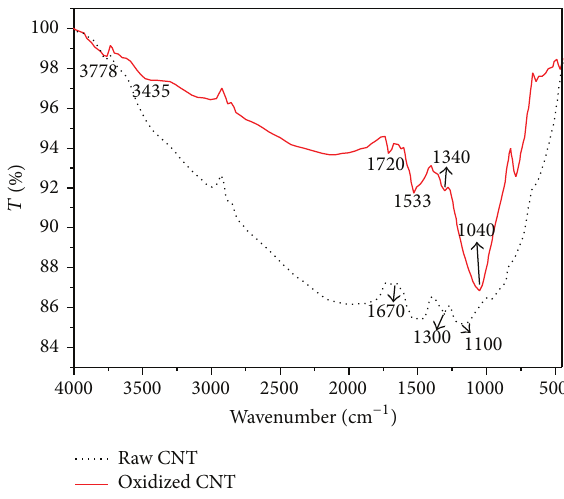
Figure 1: Infrared spectra of the raw nanotubes and the oxidized nanotubes.